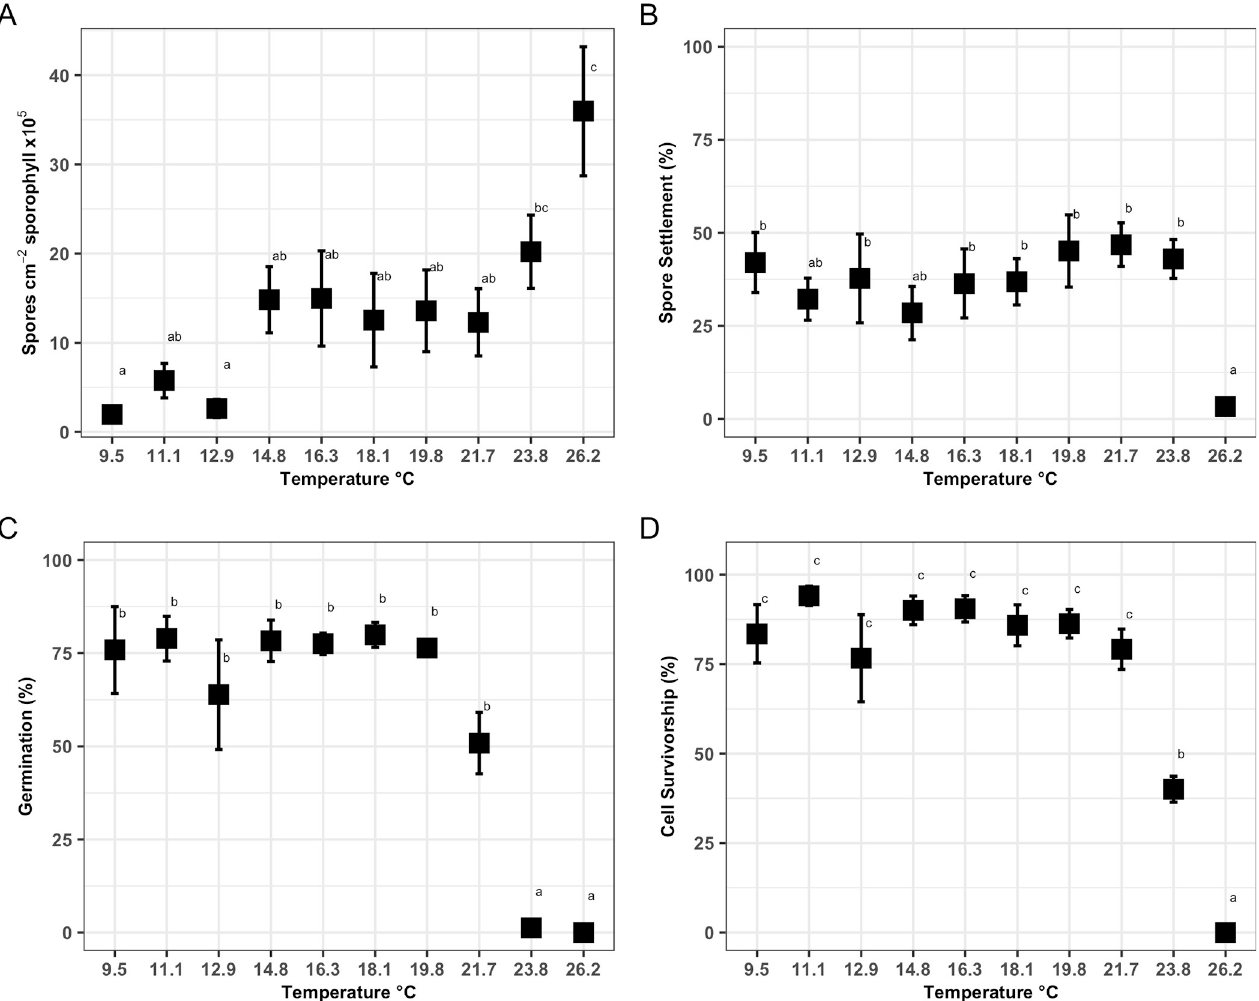
Fig 1. Physiological responses of the early life stages of M . pyrifera across 10 temperature treatments from 9.5–26.2 ± 0.2˚C. A: Mean ( ± SE) spore production after 30 min incubation time, n = 6; B: Mean ( ± SE) percentage of spore settlement 24 hours post sporulation, n = 6 (except treatment 12.9˚C: n = 5); C: Mean ( ± SE) percentage of settled spores germinated of M . pyrifera after five days, n = 6 (except treatment 12.9˚C: n = 5). D: Mean ( ± SE) percentage cell survivorship after five days, n = 6 (except treatment 12.9, 16.3, 18.1, 21.7˚C: n = 5; 19.8˚C: n = 3). Letters indicate statistical significance between treatments (Tukey-adjusted, p-value <